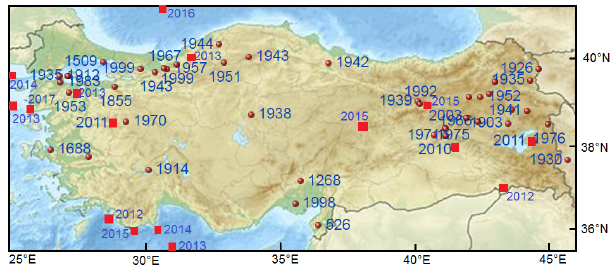
Figure 2: The historical earthquakes of Turkey (according to our literature search) with red circle and the earthquakes from 2009 to 2017 with red rectangular